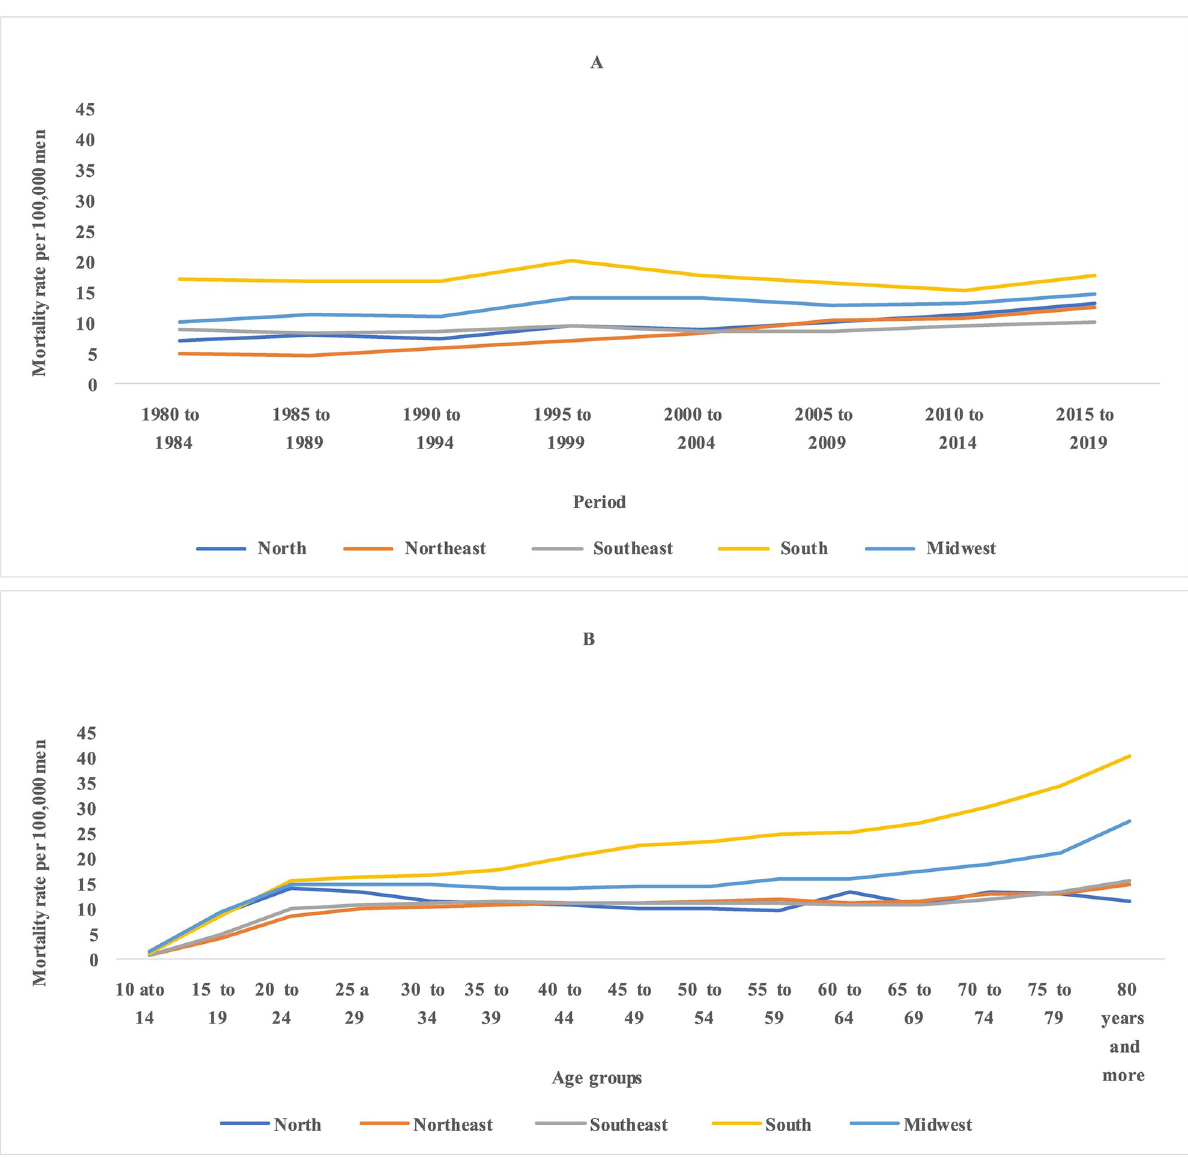
Fig 2. Total Suicide mortality rates per 100,000 men in in major Brazilian regions according to age, period, and cohort, from 1980 to 2019.